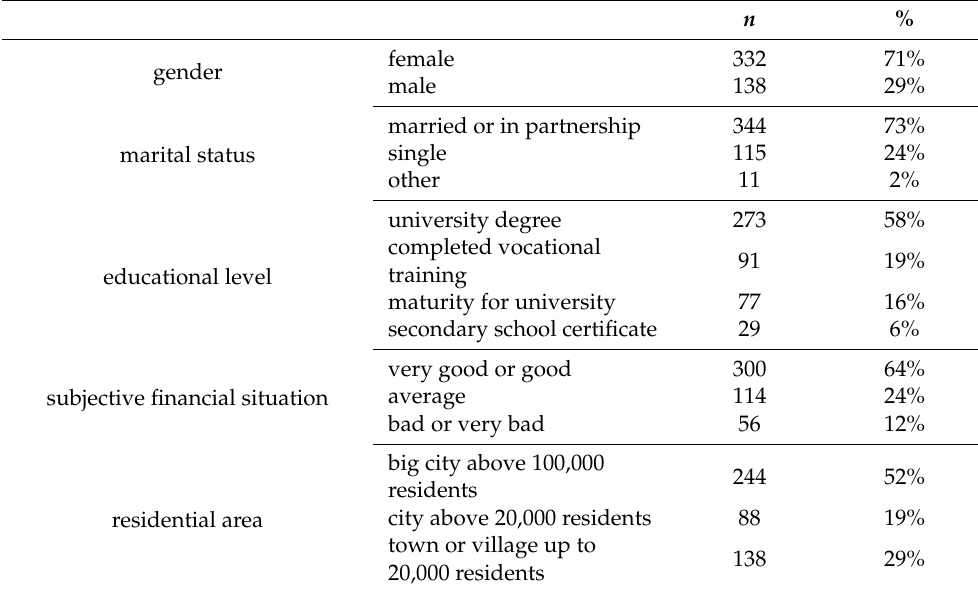
Table 1. Detailed sociodemographic characteristics of the study sample.